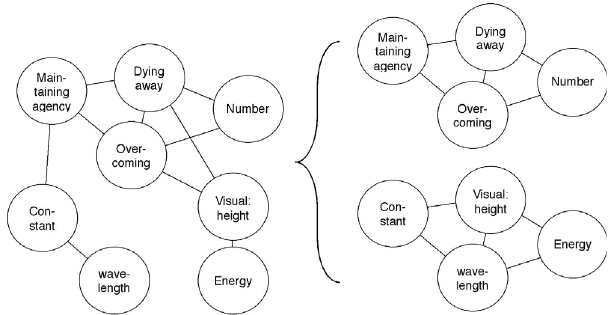
FIG. 12. Differentiation when learning quantum tunneling. A previously connected resource graph is split into two different graphs, one dealing with energy and one with number of transmitted particles.